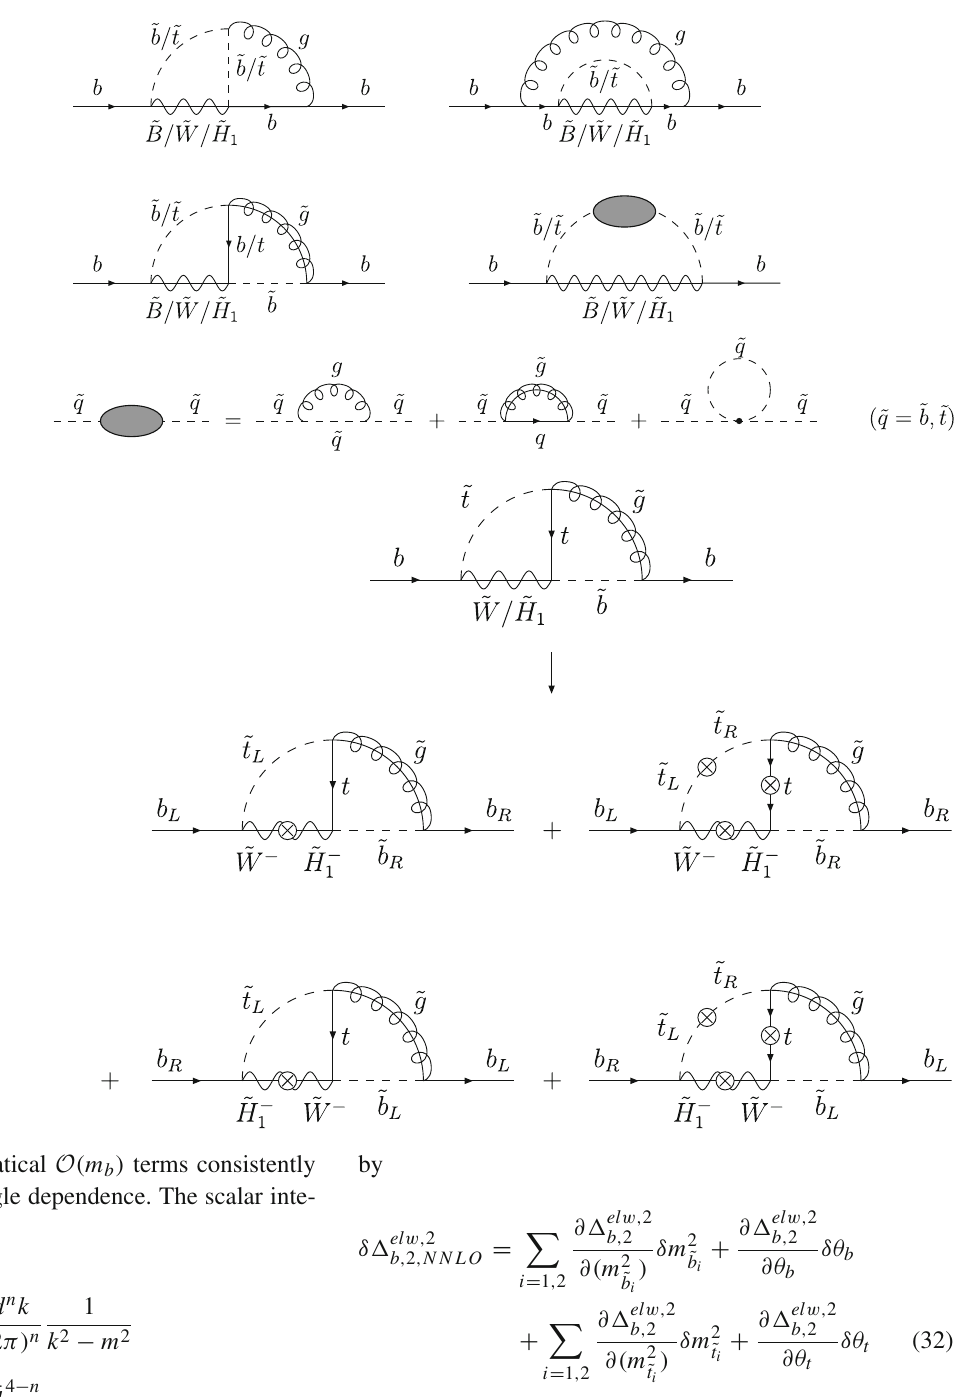
Fig. 5 Generic two-loop diagrams of the SUSY–QCD contributions to the bottom self-energy involving bottom quarks b , sbottoms ˜ b and stops ˜ t , gluons g , gluinos ˜ g , binos ˜ B , winos ˜ W and higgsinos ˜ H 0 , ±